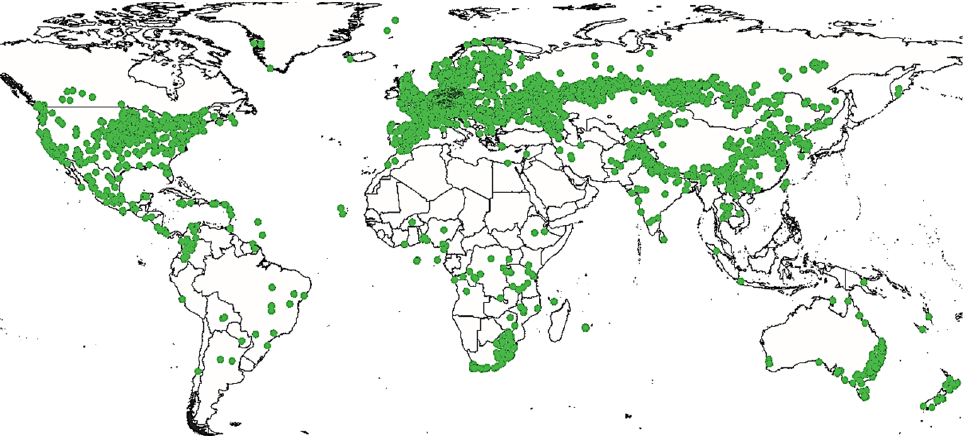
Figure 2. Geographic distribution of Cannabis sativa L.